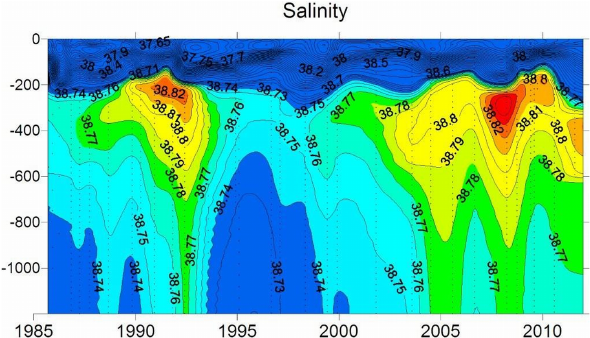
Fig. 2. Hovm¨oller diagram of the in situ salinity in the Sicily Chan- nel.